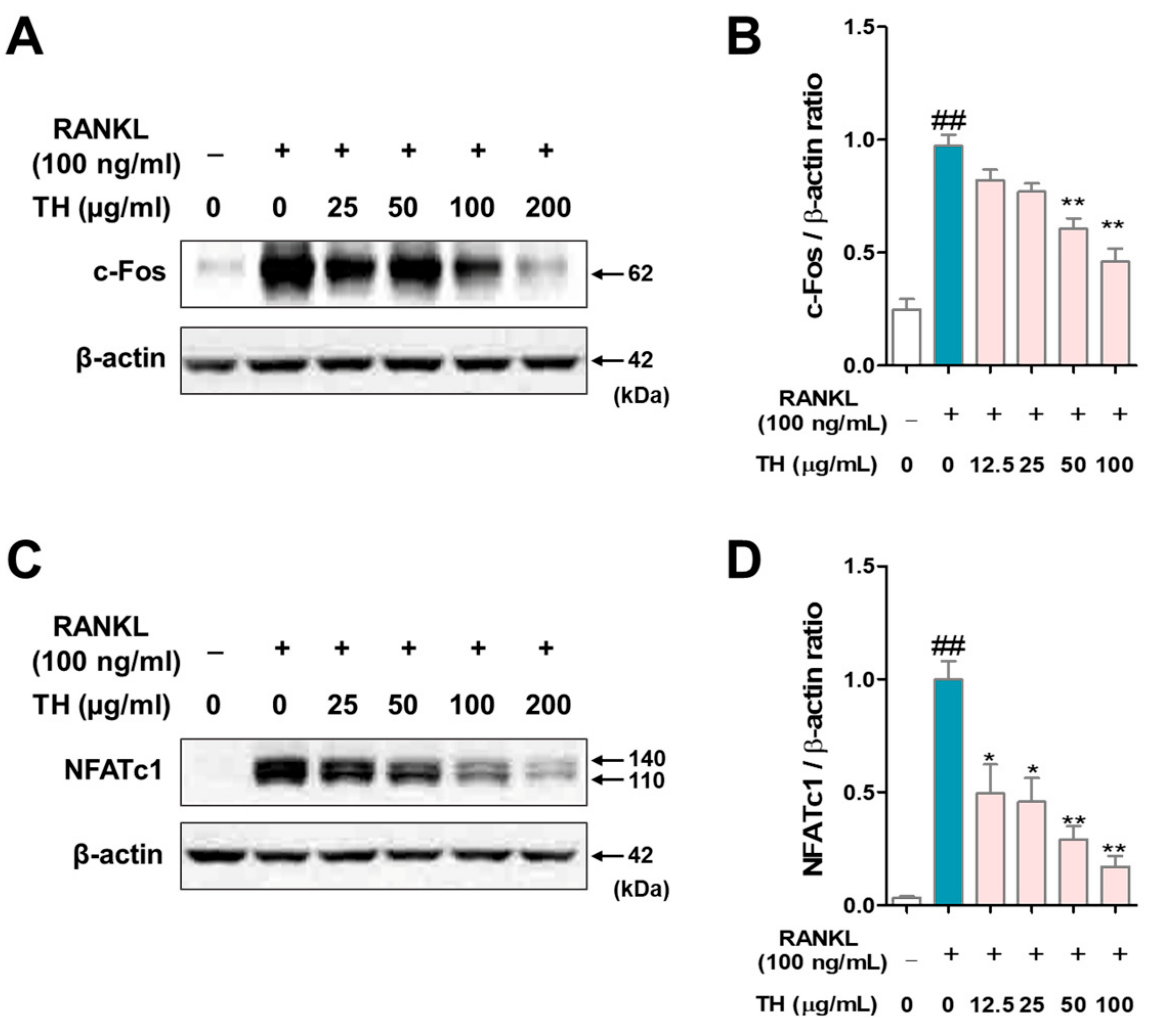
Figure 4. Taraxaci Herba (TH) treatment reduced the protein expression of c-Fos and nuclear factor of activated T cells 1 (NFATc1). ( A ) c-Fos expression was analyzed by Western blot. ( B ) c-Fos protein expression was quantified using ImageJ software Ver. 1.46 with Actb ( β -actin). ( C ) NFATc1 expression was analyzed by Western blot. ( D ) NFATc1 protein expression was quantified using ImageJ software Ver. 1.46 with Actb ( β -actin). The experiments’ representative images are shown, and the graphs are expressed as the mean ± standard error of the mean (SEM; n = 3). ## p < 0.01 vs. normal group; * p < 0.05, ** p < 0.01 vs. control group.